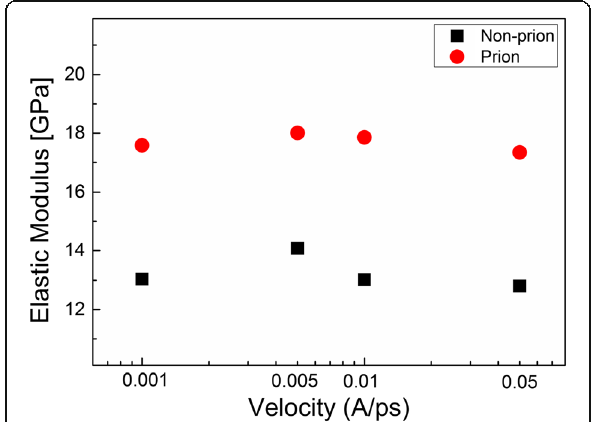
Fig. 3 Elastic modulus of prion and non-prion fibrils as a function of pulling